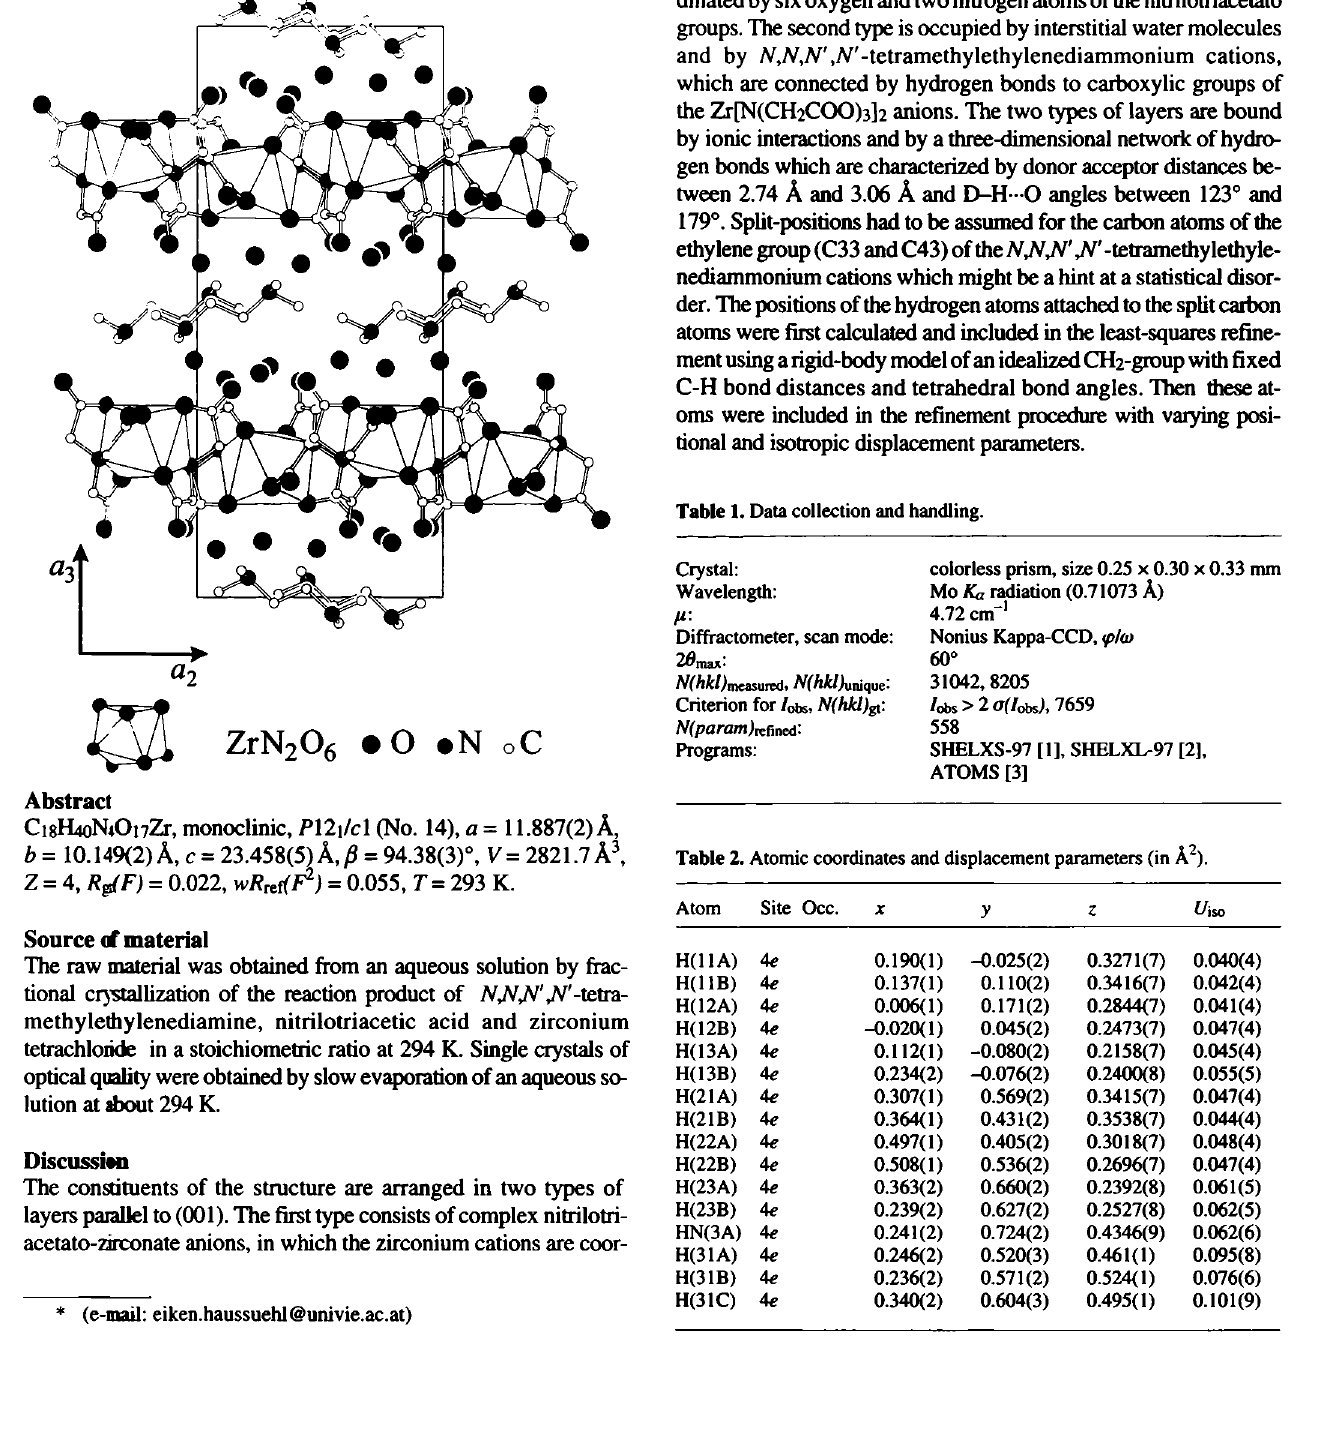
Table 2. Atomic coordinates and displacement parameters (in Â 2